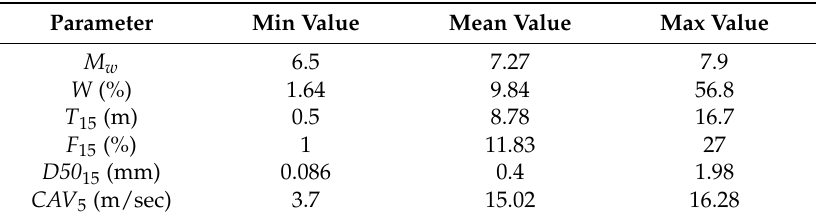
Table 3. Characteristics of database with F 15 ≤ 28% used for the second developed ANN model and RSM equation.